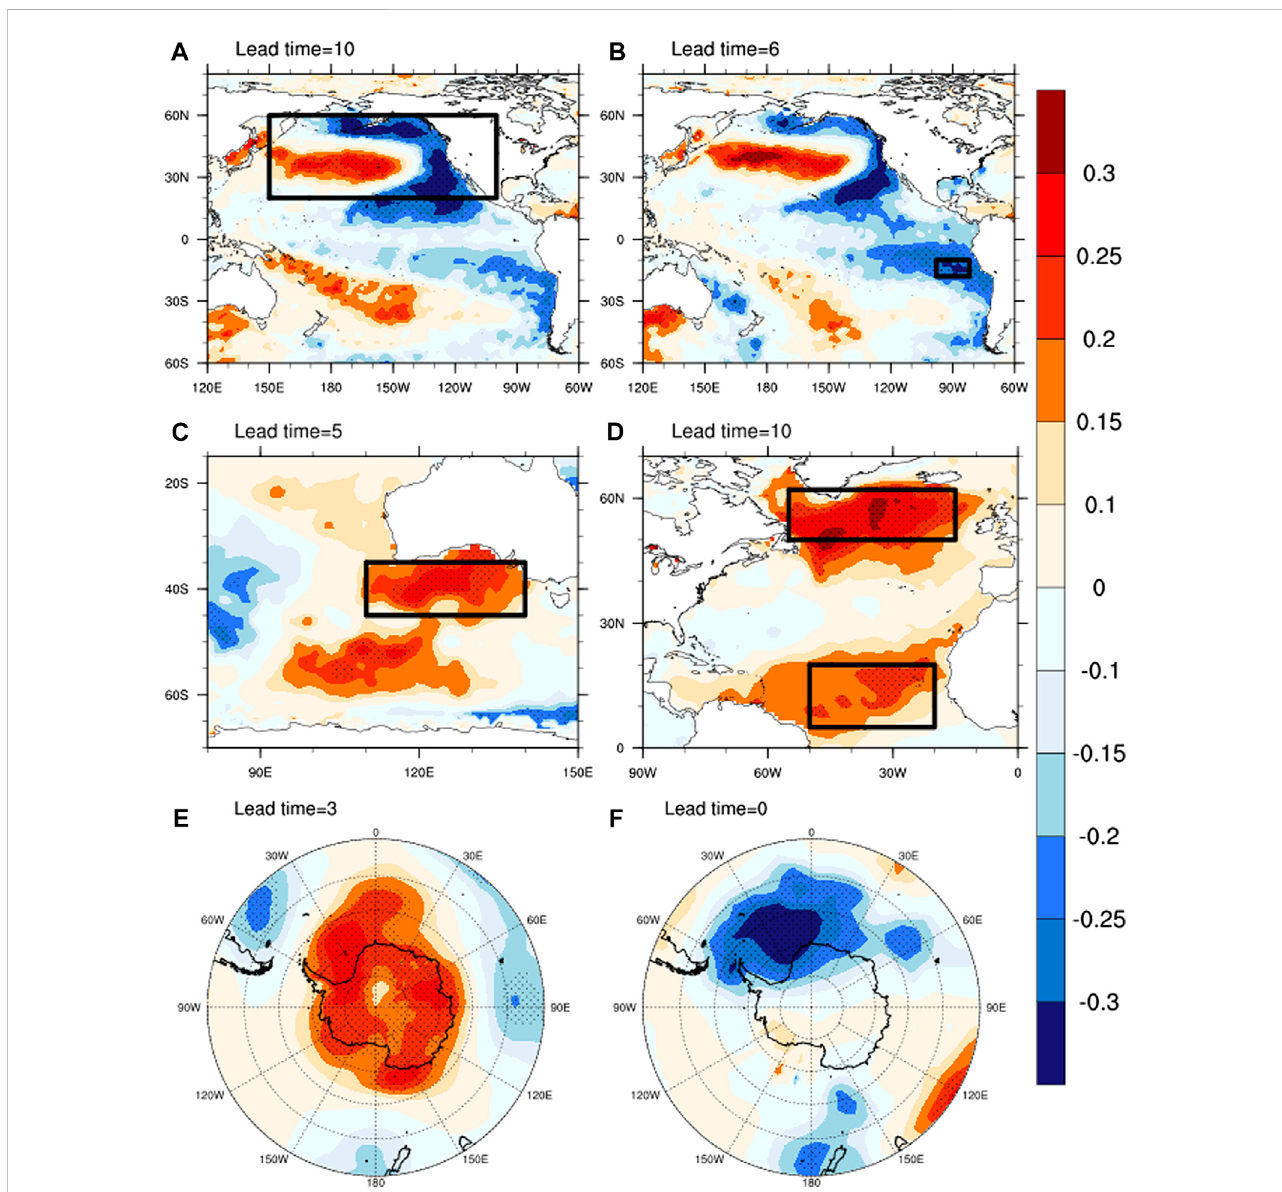
FIGURE 4 Correlationcoef fi cientsbetweenWeddellSeaSICandSST (A – D) ,SLP (E) andSAT (F) atdifferentleadingtimes.Theleadingtimesareindicatedontheleft of each panel. The key oceanic regions related to the Weddell Sea SIC shown in the black boxes. The stippling in all the panels denotes the 95% con fi dence level based on the two-sided student t